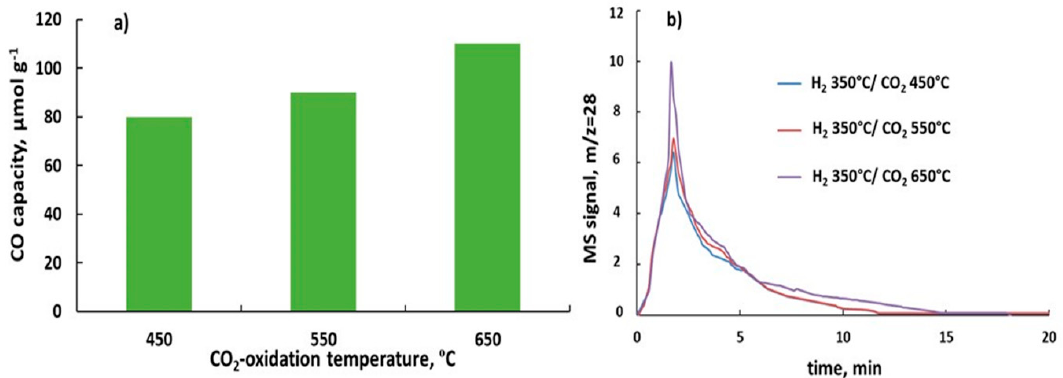
Figure 7. Effect of CO 2 oxidation temperature in RWGS-CL cycles at constant H 2 -reduction at 350 °C